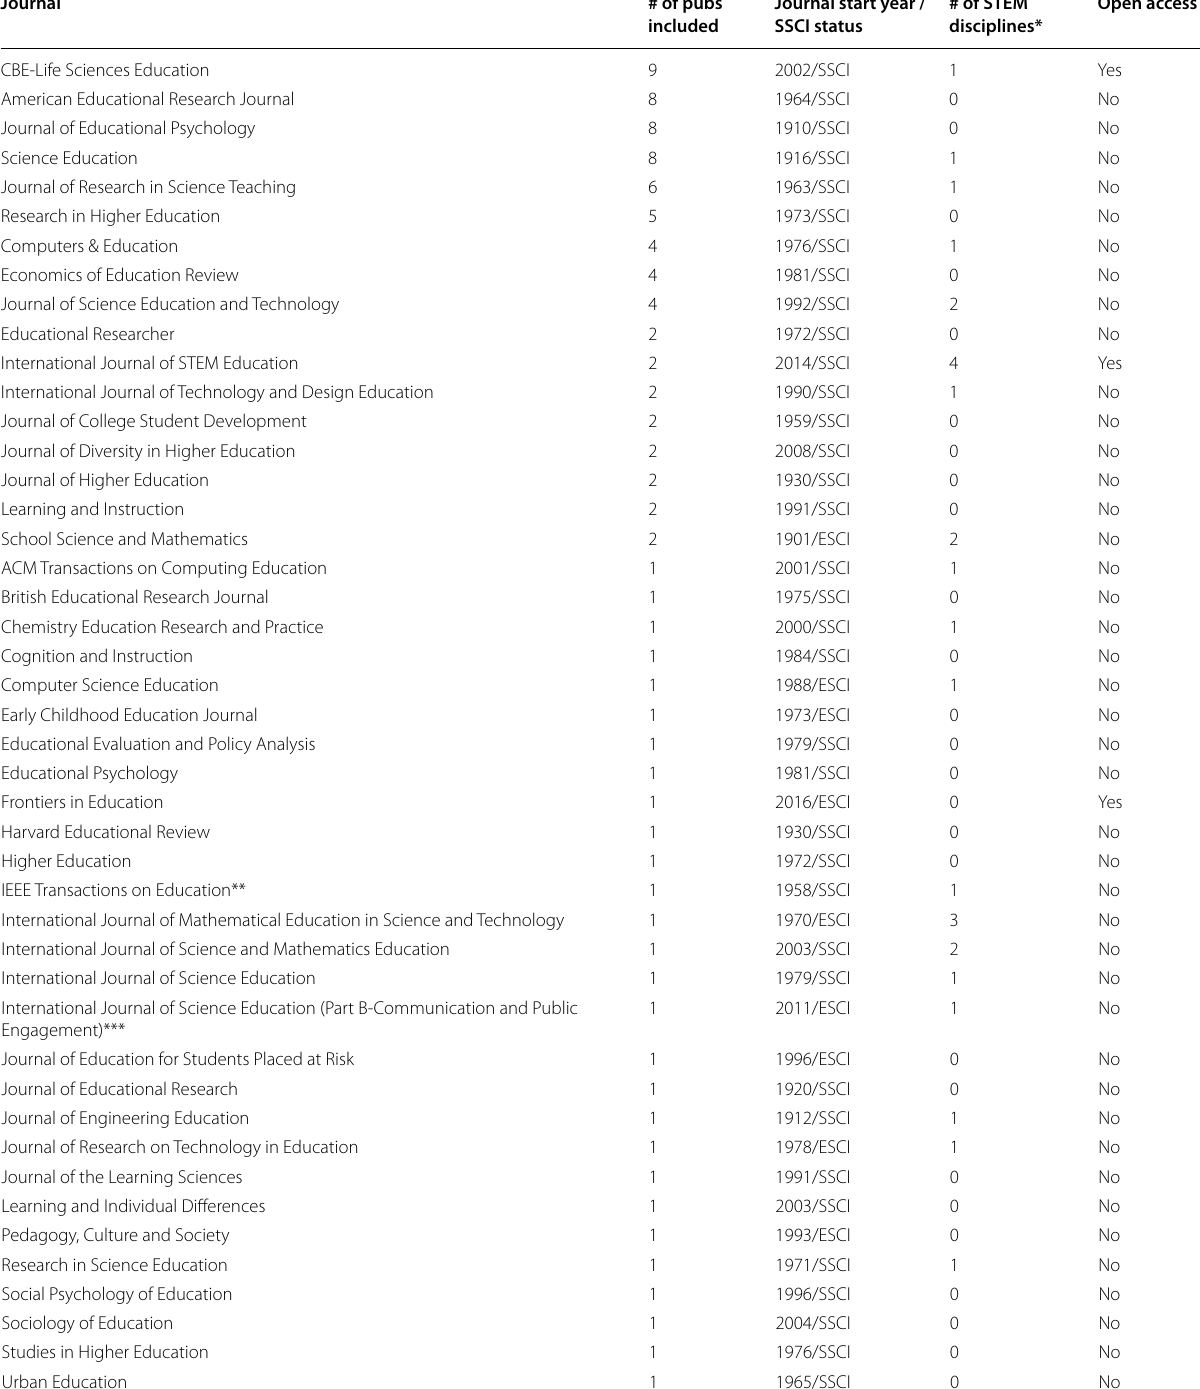
Table 4 Distribution of top 100 most-cited empirical research publications in 45